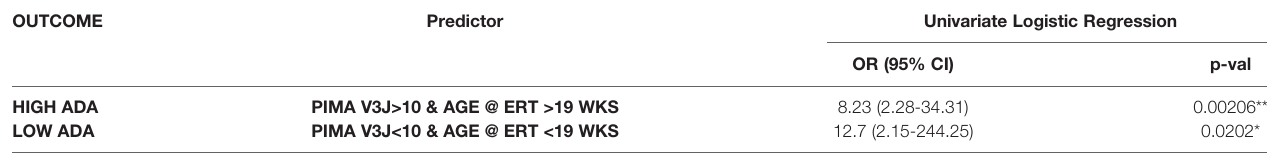
TABLE 2 | Combined logistic regression model for high and low ADA risk. OUTCOME